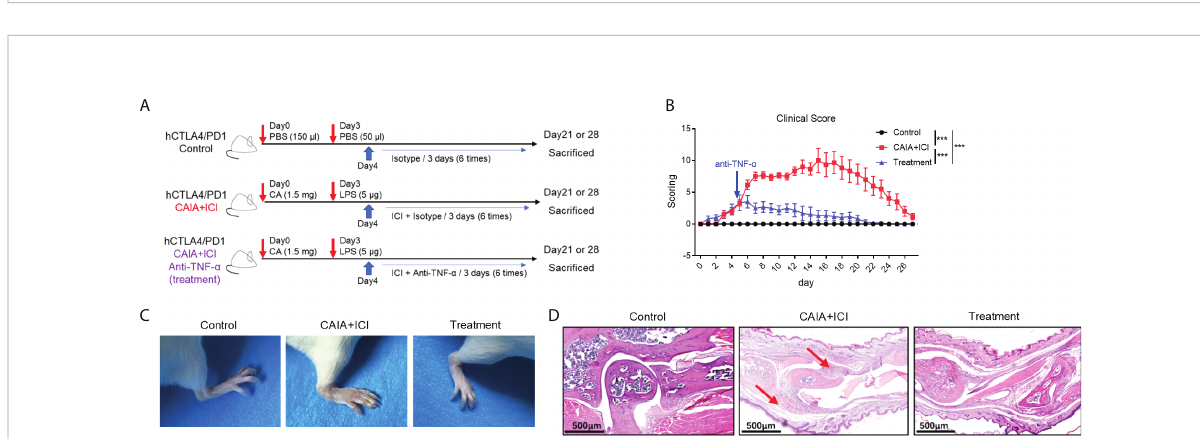
FIGURE 3 Anti-TNF- a treatment ameliorates the severity of ICI-related arthritis and pneumonitis in humanized mice. (A) A diagram illustrated the experimental design. (B) The dynamics of clinical arthritic scores in mice. (C) Representative images of paw swelling and ankle joints in mice. (D) Representative images of the ankle joints in mice after HE staining. Arrows indicate lymphocyte in fi ltrates and soft tissue injury in mice. Data are representative images or presented as means ± SEM of each group (n=6) of mice. Statistical signi fi cance was analyzed by one-way ANOVA and host hoc Bonferroni test or Kruskal-Wallis H test. *** p <